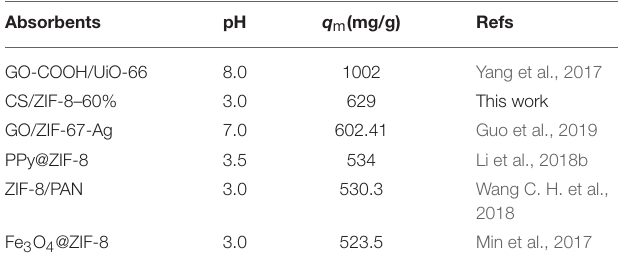
TABLE 1 | Comparison of the maximum adsorption capacity of CS/ZIF-8–60% with other MOF-based adsorbents.